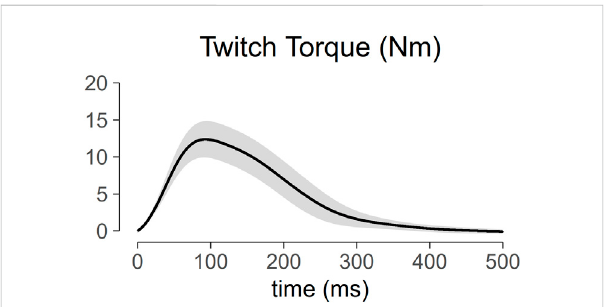
Pro fi le of muscle twitch torque generated at maximum stimulus intensity(S-100).Thesolidlinerepresentsthemeanofthe22subjects, and the ribbon represents the standard deviation.